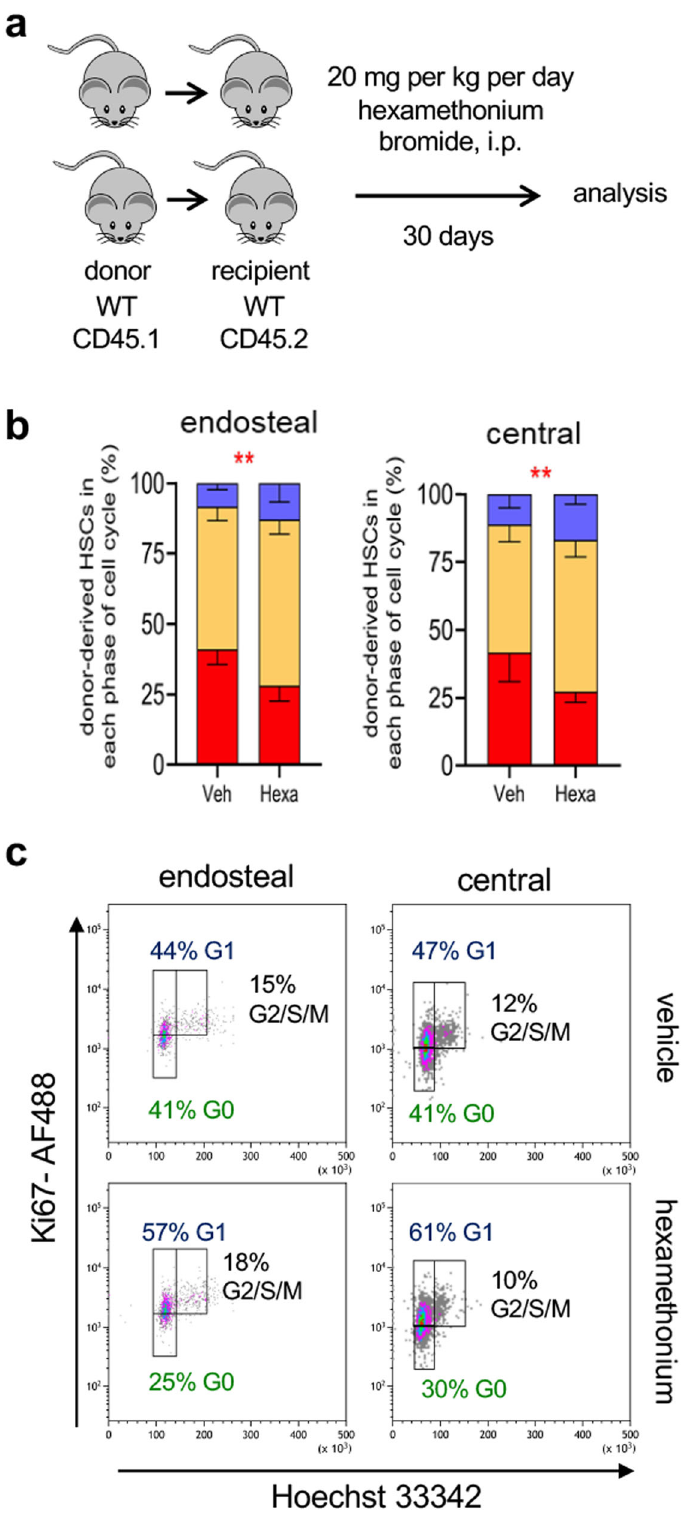
Fig. 8 Nicotinic receptor blockade reduces HSC quiescence after transplantation. a Scheme illustrating the treatment of sub-lethally irradiated WT CD45.2 recipients of 2 × 10 6 BM nucleated cells from CD45.1 mice, treated with Hexamethonium bromide (20 mg/kg/d over 30d, i.p.) or vehicle. b Cell cycle pro fi les of donor-derived (CD45.1 + ) lin - sca1 + ckit + (LSK) CD34 - fl t3 - HSCs isolated from the endosteal or central BM 30 days after transplantation and chronic treatment with hexamethonium bromide or vehicle ( N = 5 ;P = 0.002,005). Data are mean of biological replicates ± SEM. ** P < 0.01. ANOVA and Sidak ’ s comparisons. c Representative fl ow cytometry plots showing HSCs in different phases of the cell cycle. The frequencies of the gated populations are